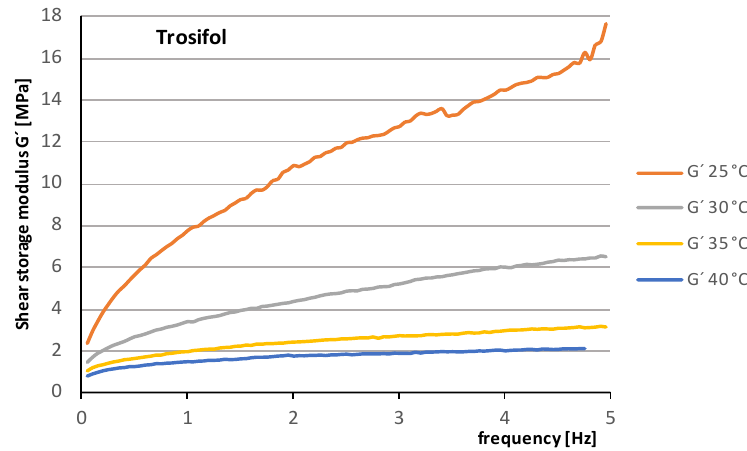
Fig. 10 Storage modulus-frequency curves of representative Trosifol interlayer obtained by DMTA.